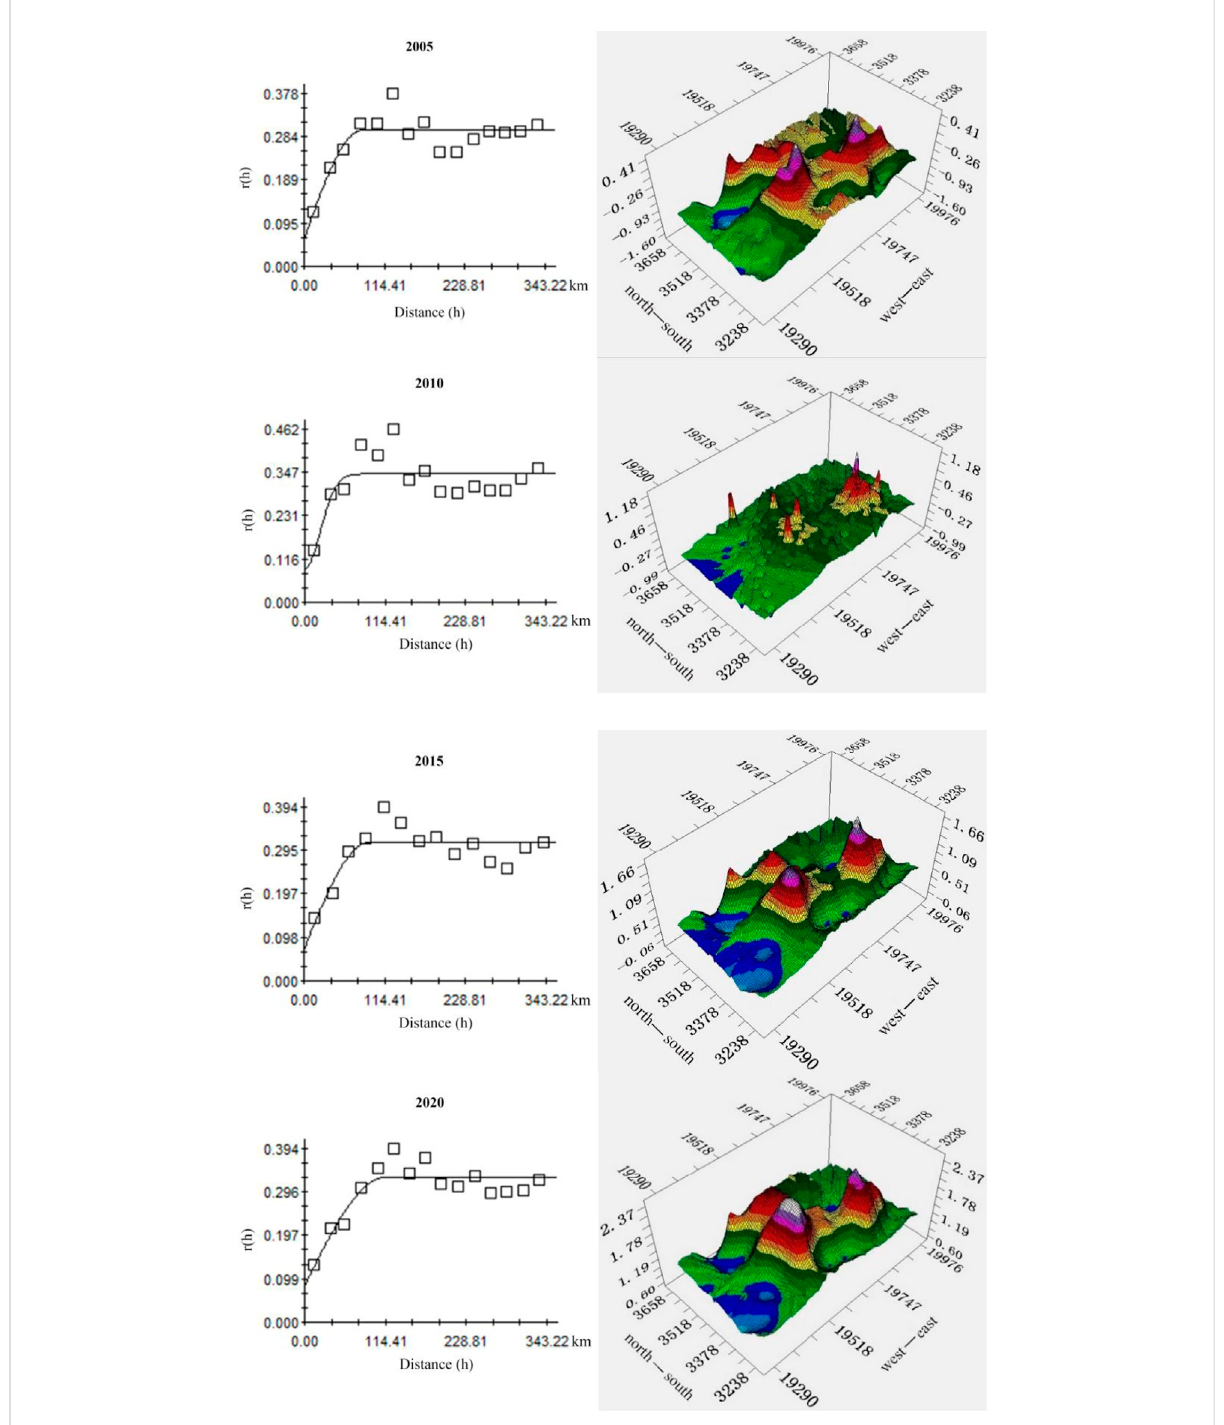
FIGURE 9 Evolvement of variogram on spatial pattern of county economy in Hubei province (left: covariance fi tting chart and right: kriging interpolation 3D fi tting